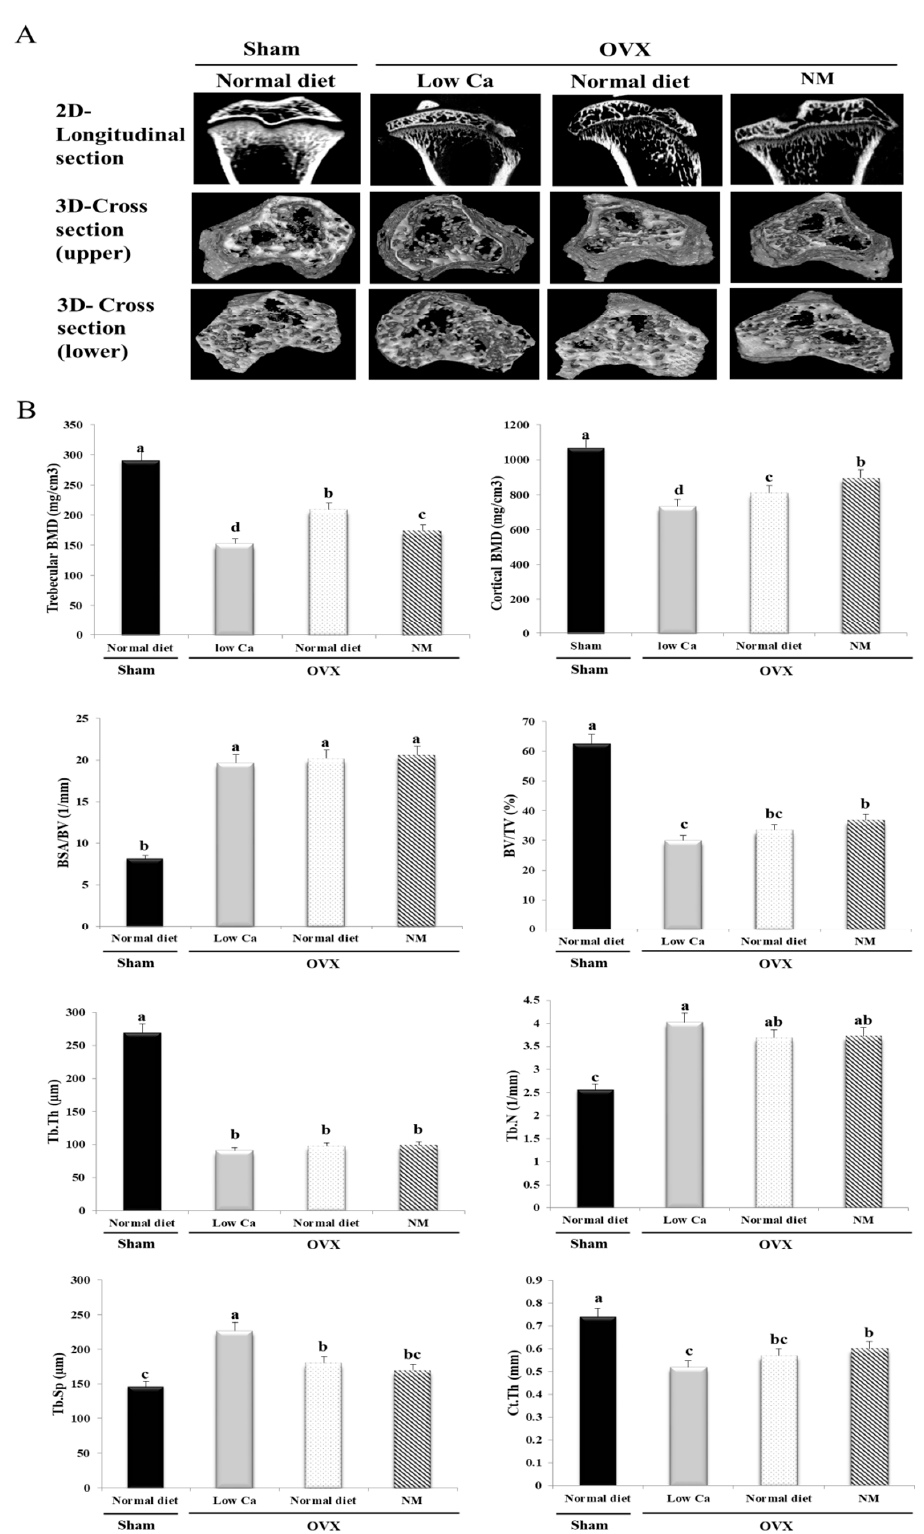
Figure 5. Tibial bone microstructure of ovariectomized (OVX) rats. ( A ) Longitudinal and cross-sections of trabeculae. ( B ) Trabecular bone and cortical bone analysis. Each value is expressed as the mean ± SD. Values not sharing a common superscript (a-c) di ff ered significantly (Duncan’s multiple range test) ( p <